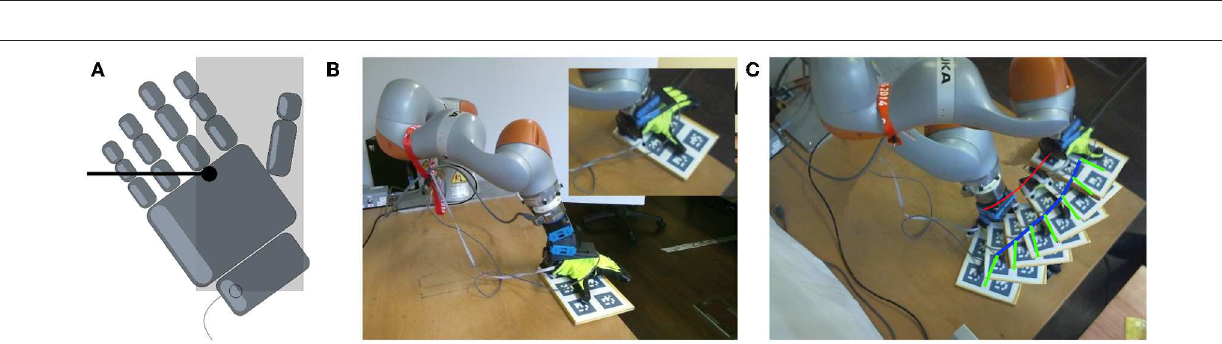
FIGURE 1 | First row: Sketches of (A) the object to be grasped and its dimensions, (B) Strategy 1: Continuous Slide and Grasp, and (C) Strategy 2: Pivot and Re-Grasp. Second and third rows: real-world implementation of (D) Strategy 1: Continuous Slide and Grasp, and (E) Strategy 2: Pivot and Re-Grasp.